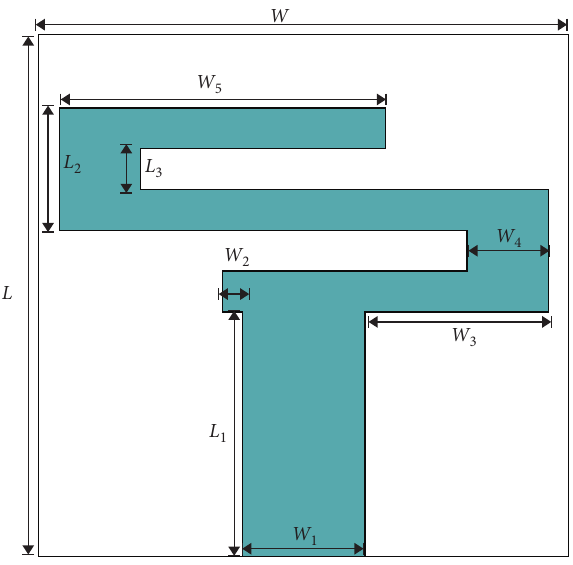
Figure 1: Design of the proposed single